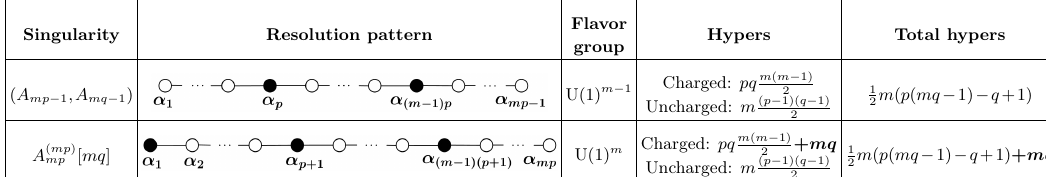
Table 2 . Higgs Branch data for quasi-homogeneous cDV singularities of A